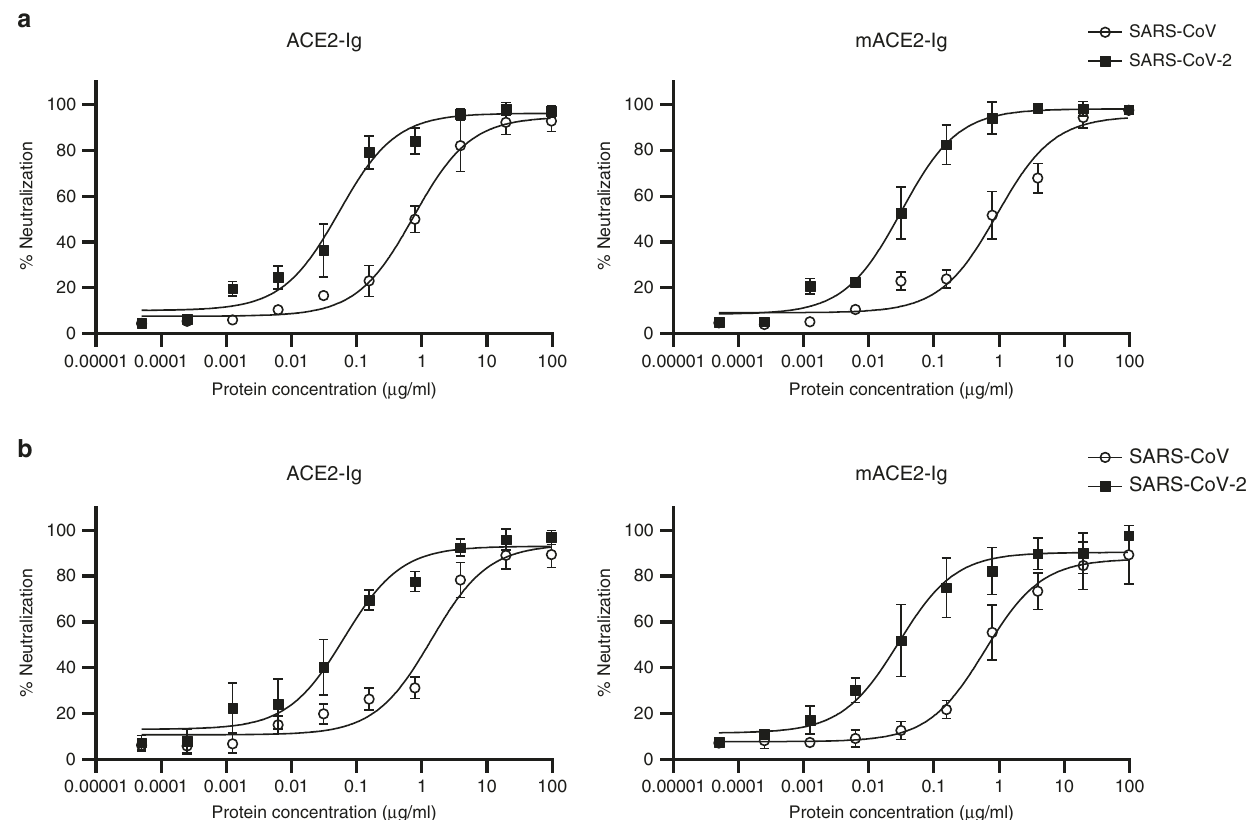
Fig. 2 ACE2-Ig potently neutralizes viruses pseudotyped with the S glycoproteins. HIVs pseudotyped with the S glycoproteins from CoVs were incubated with different fusion proteins for 1 h before infection. Luciferase activities in target 293 T cells ( a ) and A549 cells ( b ) were measured, and the percent neutralization was calculated. Data are the means ± s.d. of four independent biological replicates. Source data ( a , b ) are provided as a Source Data fi